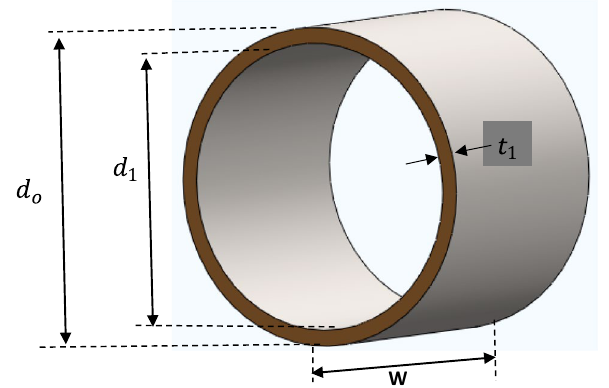
Figure 4. Hollow cylinder of the Pulley.